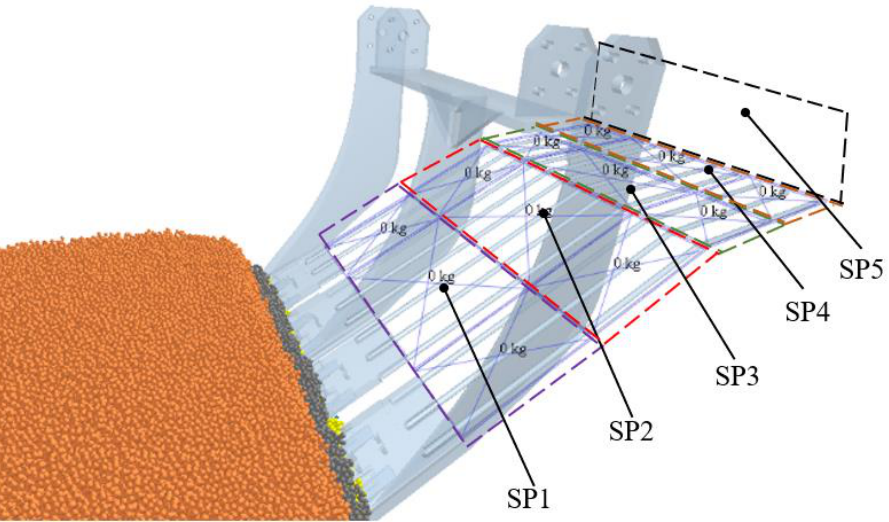
Figure 8. Monitoring areas division and follower total mass sensors arrangement.